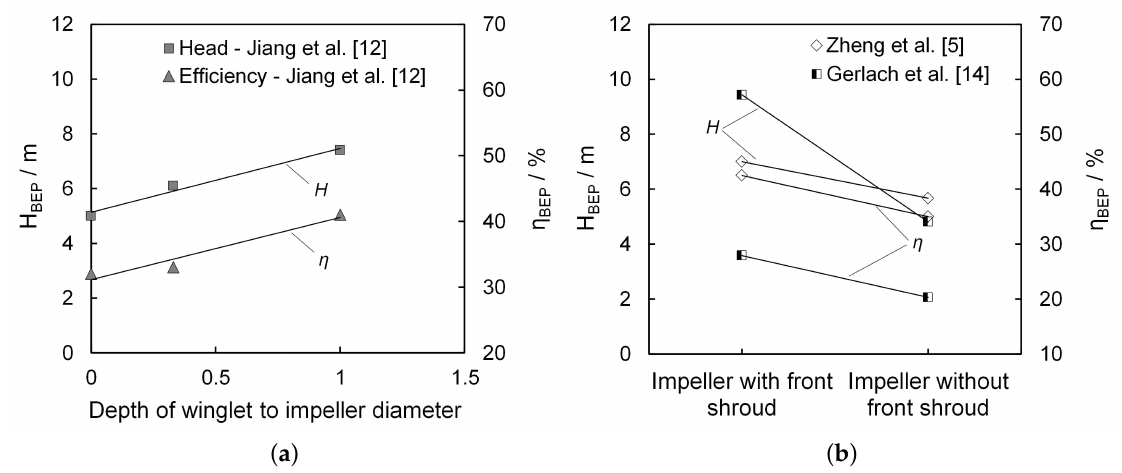
Figure 15. ( a ) Head and efficiency over depth of winglet.; and ( b ) head and efficiency for impellers with and without a front shroud.